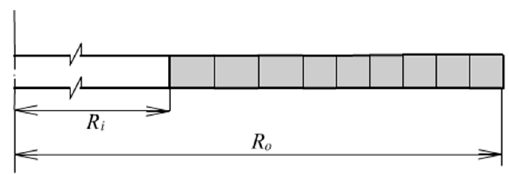
Figure 9. Sketchy of the FEM mesh of the cylinder.